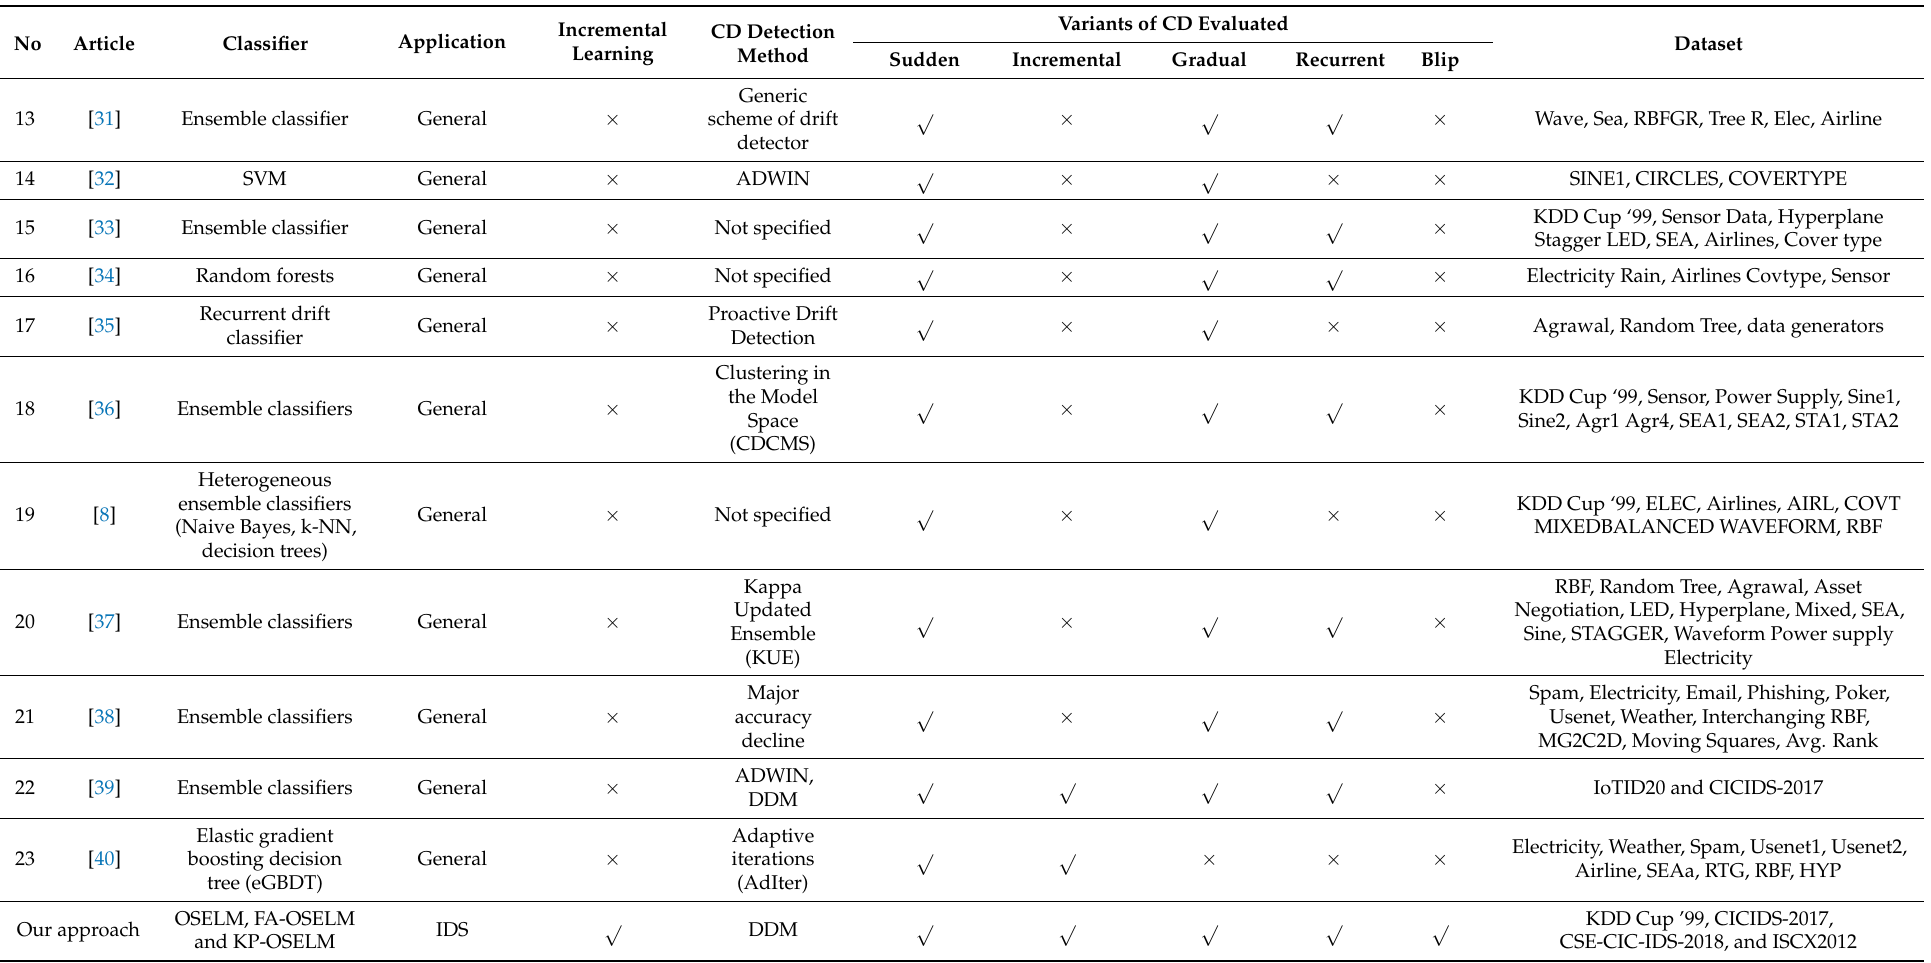
Table 2. Overview of existing models for data stream prediction with an awareness and handling of CD with the variants of drifts used for